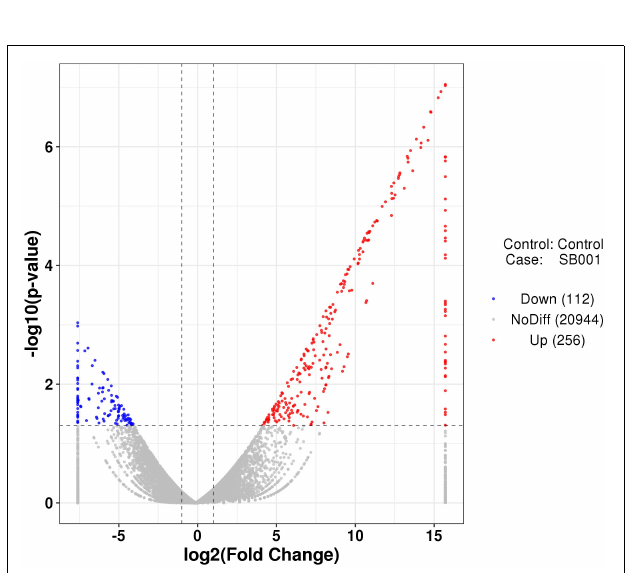
FIGURE 7 | Volcanic diagrams of differential expression genes. The horizontal coordinates are log2 (fold change) and the ordinates are -log10 ( p -value). The two vertical dashed lines are 2 times the difference threshold, and the horizontal dashed lines are p -value 0.05 thresholds. A red dot indicates the upregulated genes group, a blue dot indicates the downregulated genes group, and a grey dot represents a non-significant difference in the expression of the genes group. The scale was fixed considering the minimum and maximum log2 values (between -7.60 and 15.70) included in the Supplementary Table 4